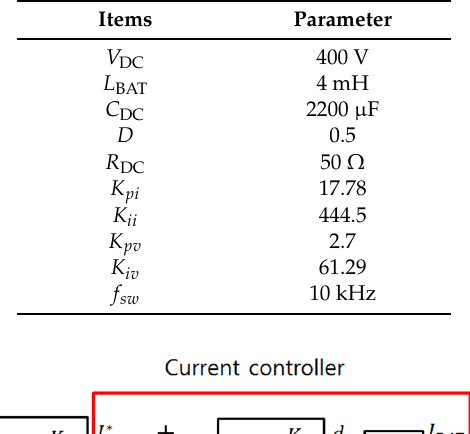
Table 1. Circuit and PI control parameters for a bidirectional chopper.